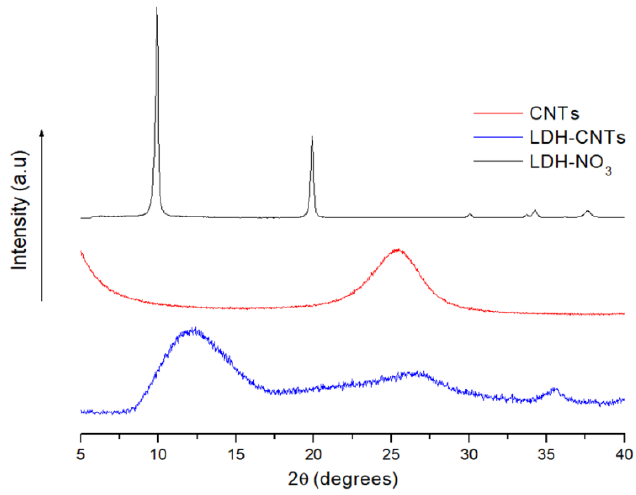
Figure 3. The XRD of LDH in nitrate form, the CNTs and the hybrid LDH-CNTs.